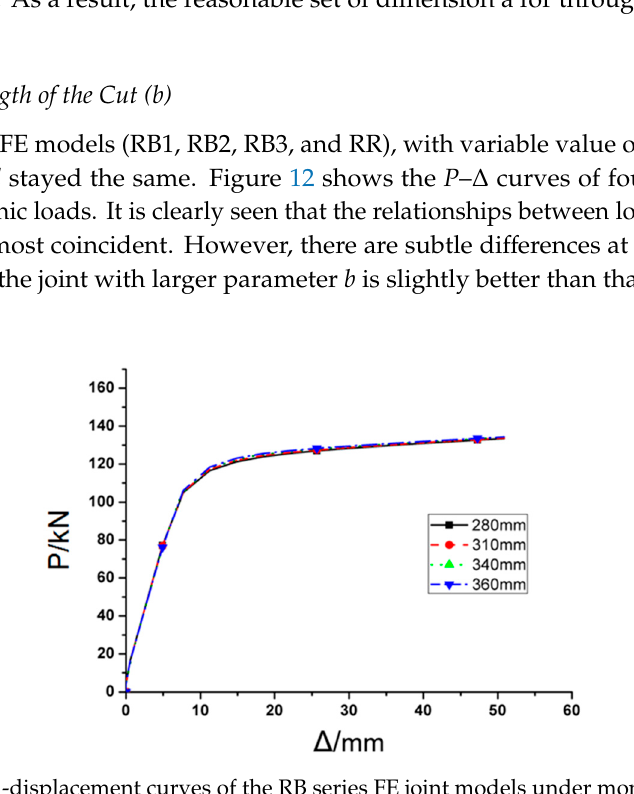
Figure 12. The load-displacement curves of the RB series FE joint models under monotonous loading.